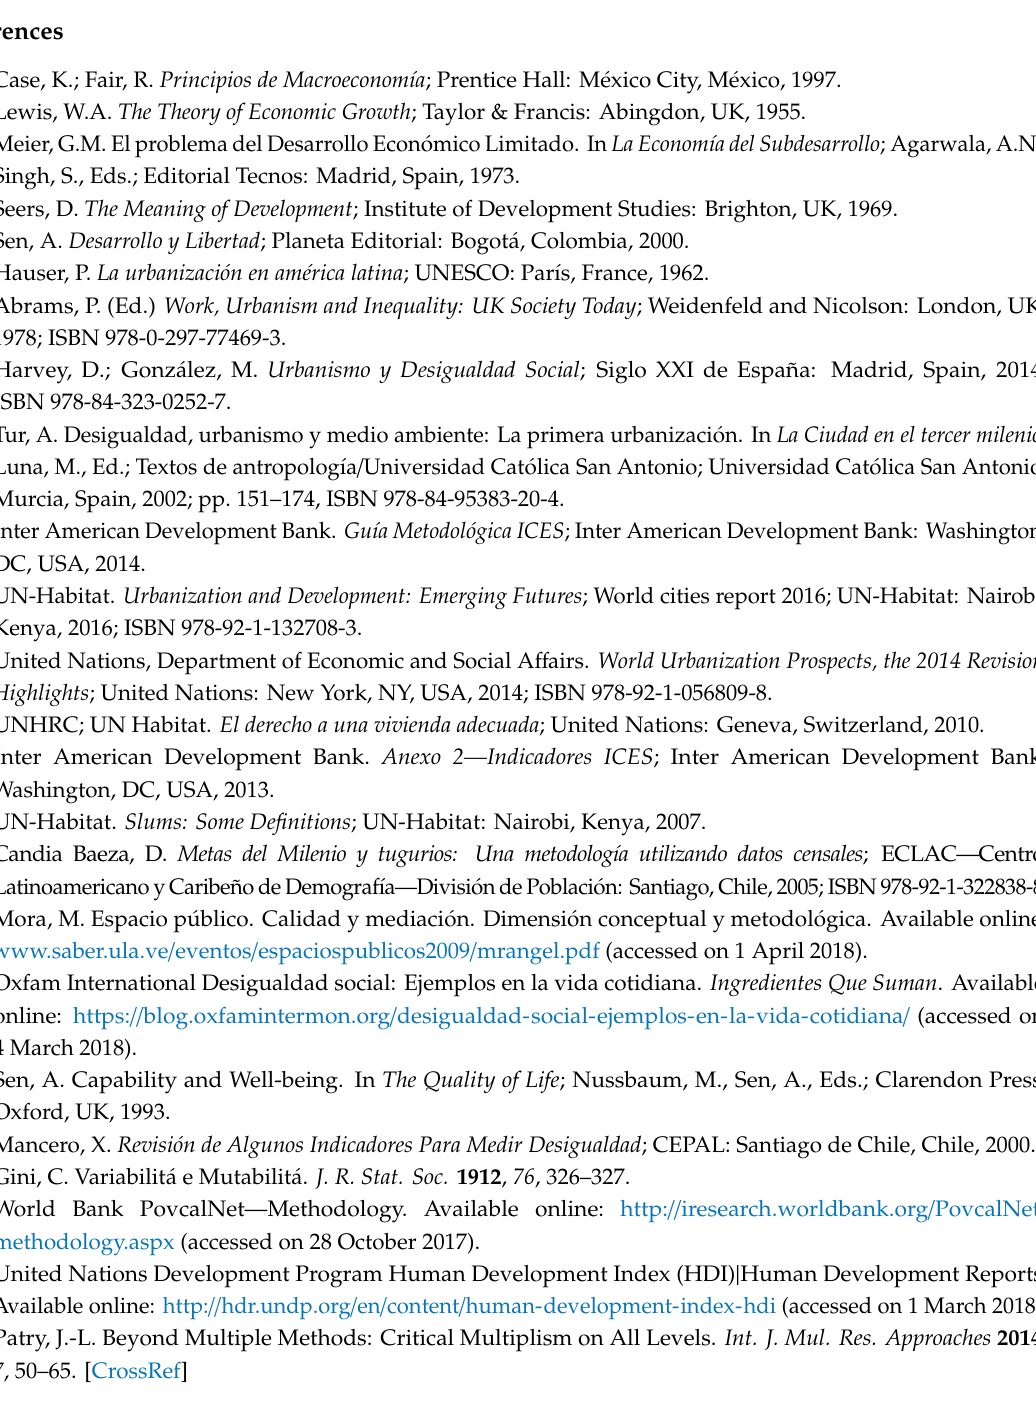
Table S2: UrbanDevInequalityCorrelation.pdf-correlation analysis